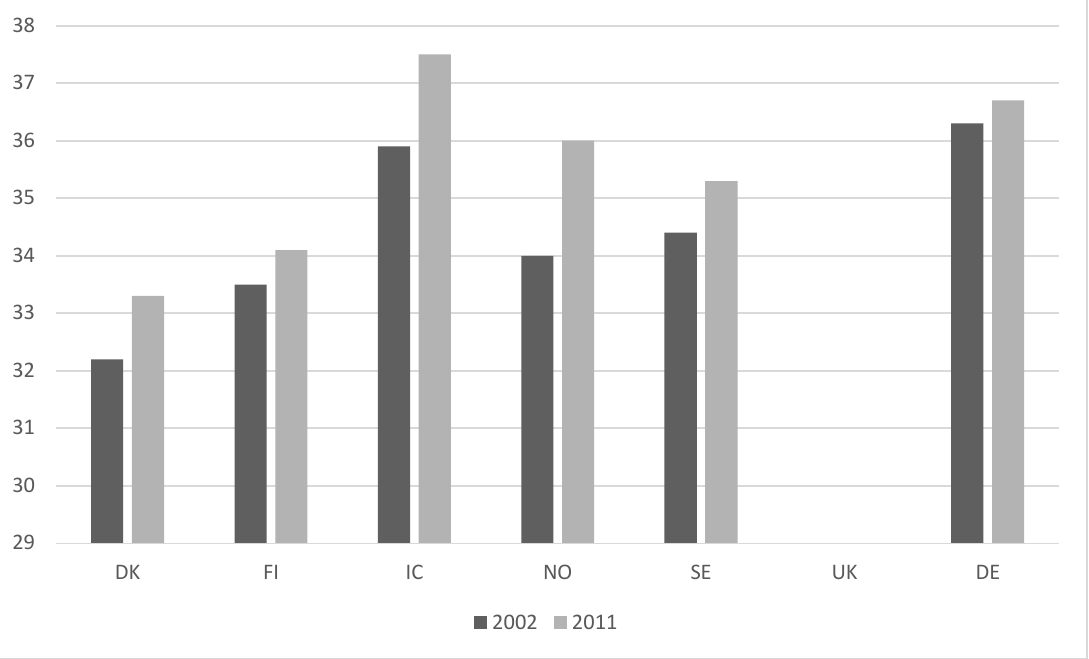
Source: OECD Statistics, (OECD, 2017a).